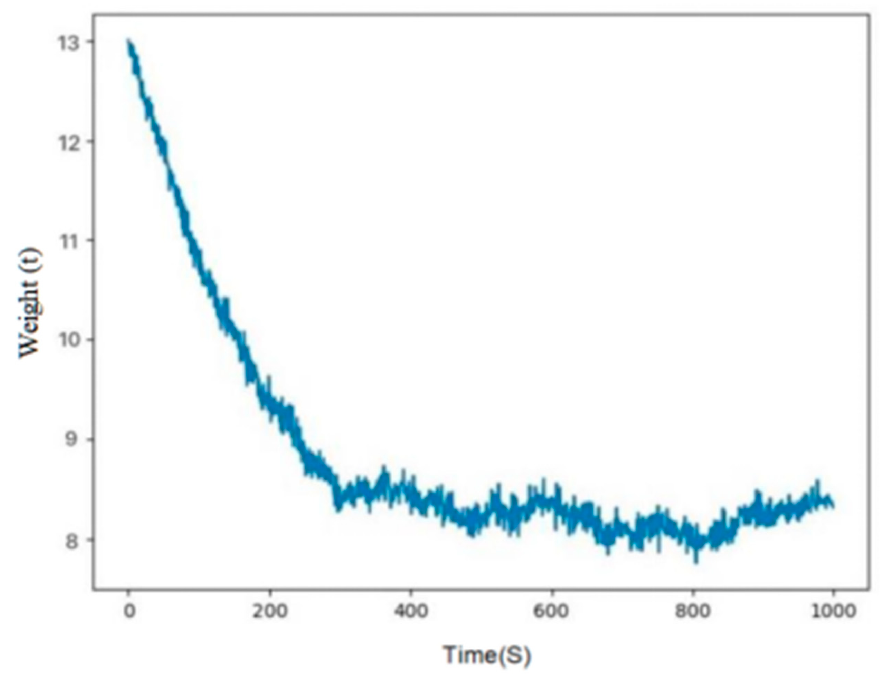
Figure 15. Fuzzy control response curve to changing production conditions.